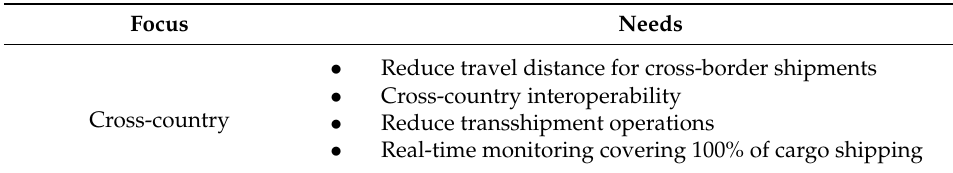
Table 1. Specific requirements of cross-country parcel